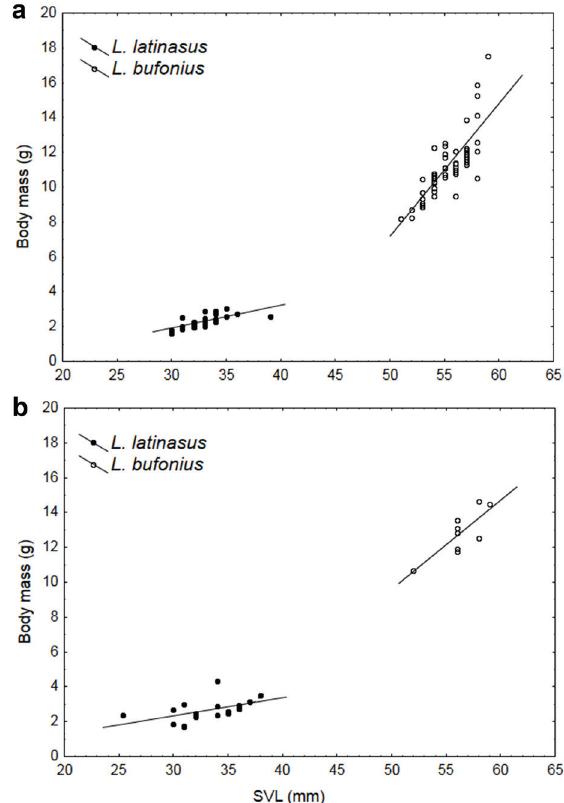
Figure 1 - Snout-vent length (SVl) and body mass (BM) relationships in Leptodactylus latinasus and L. bufonius males ( a ) and females ( b